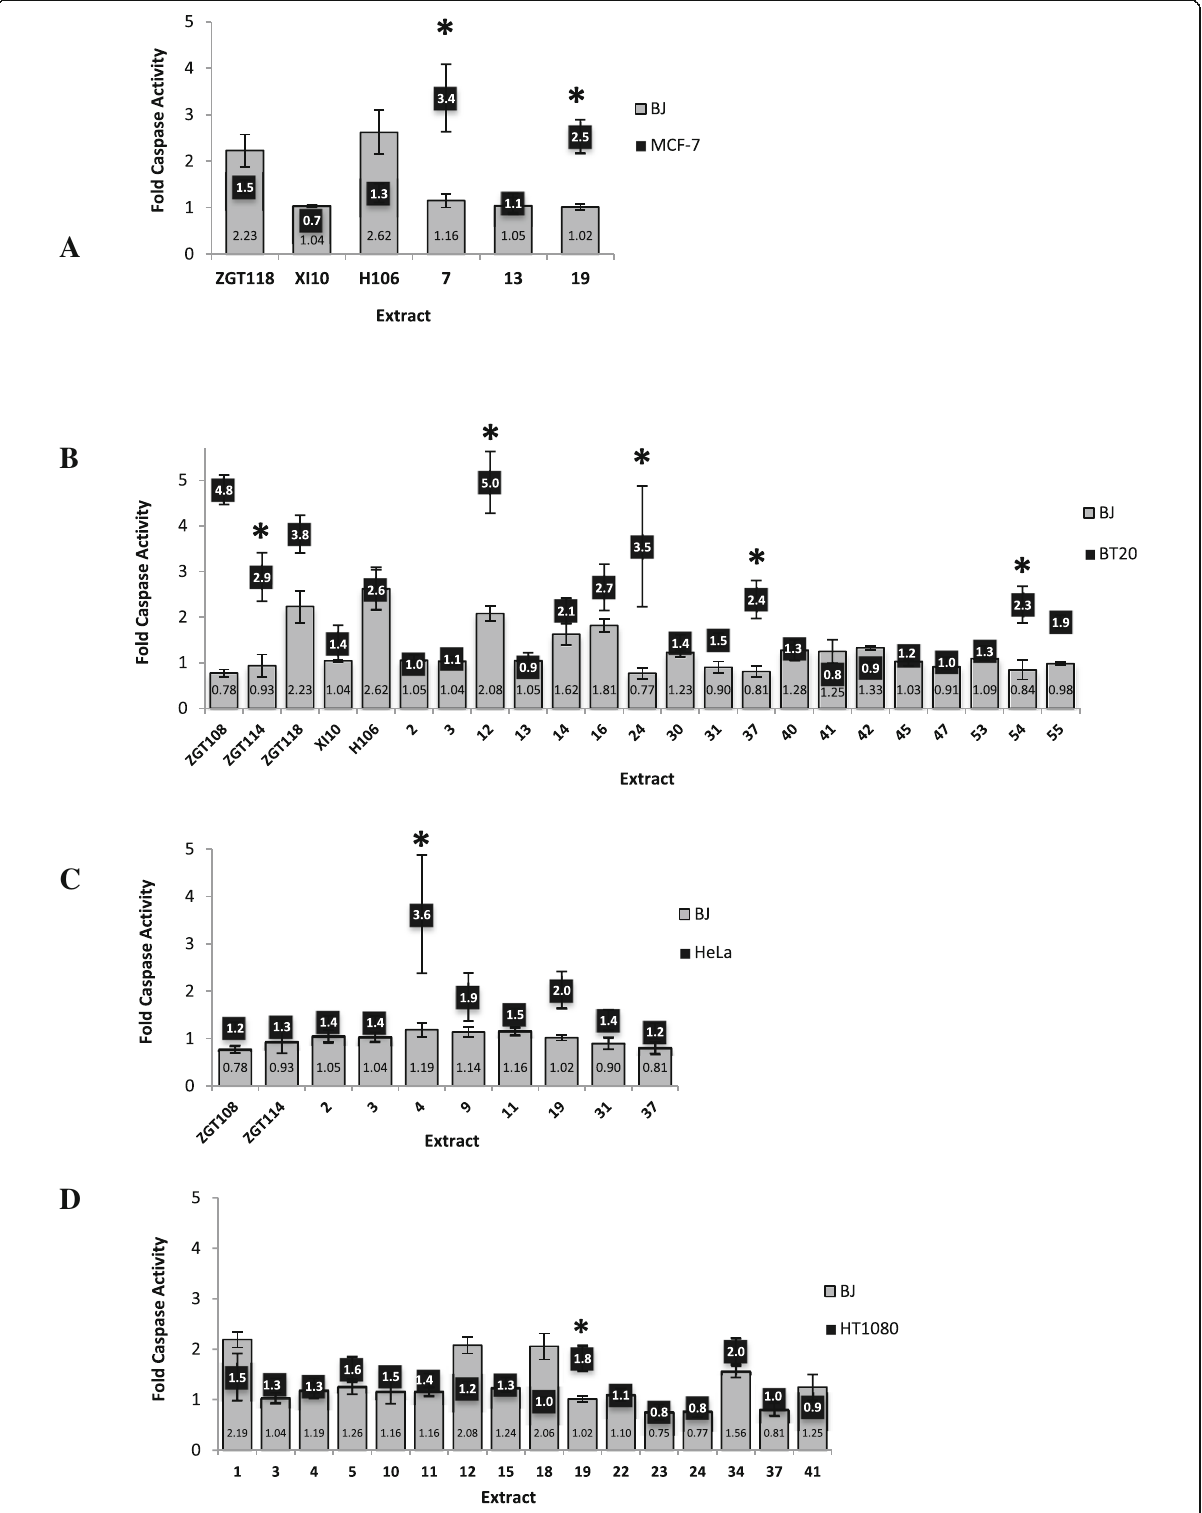
Fig. 2 Caspase 3/7 Activity in cells treated with bacterial extract. Normal skin fibroblast cell line BJ and four cancer cell lines MCF-7, BT20, HeLa and HT1080 were treated with 200 μ g/ml bacterial extract for 48 h ( a - d ). Fold change in Caspase-3/7 activity relative to untreated was determined as per manufacturer ’ s instructions and students t-test was used to determine significance where * indicates p <